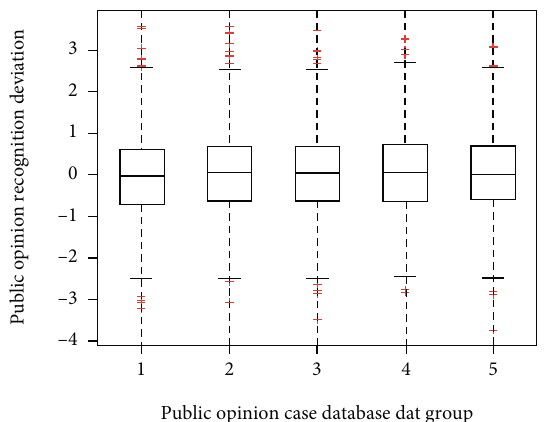
Figure 6: Box diagram of network public opinion data identi fi cation